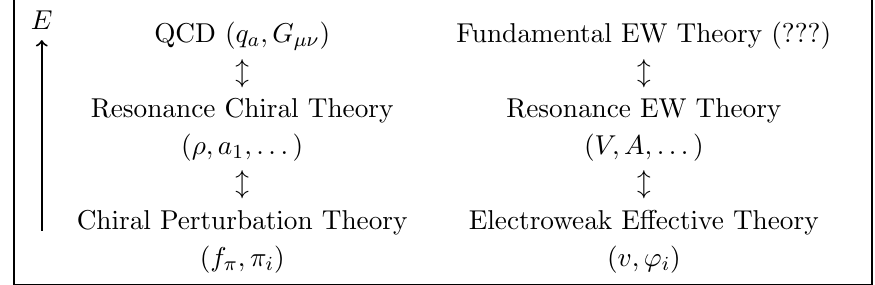
Figure 1 . Schematic view of the energy regimes of the di(cid:11)erent (e(cid:11)ective) theories. A possible UV completion of the SM electroweak sector could behave somehow similarly to